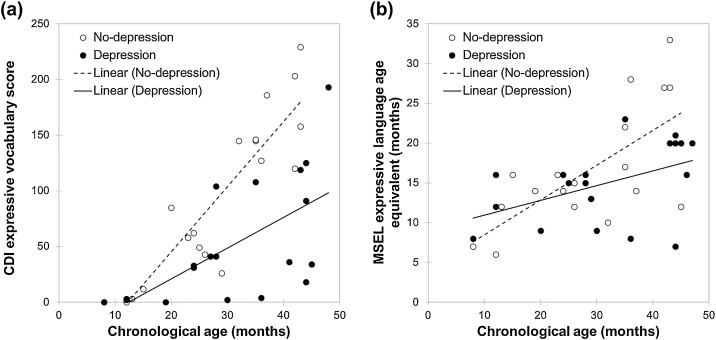
Cross-sectional developmental trajectories comparing children with DS with and without parents who reported having had a diagnosis of depression (the Depression and No-depression groups, respectively) on (a) CDI expressive vocabulary score plotted against chronological age (months); and (b) MSEL expressive language age equivalent (months) plotted against chronological age (months).